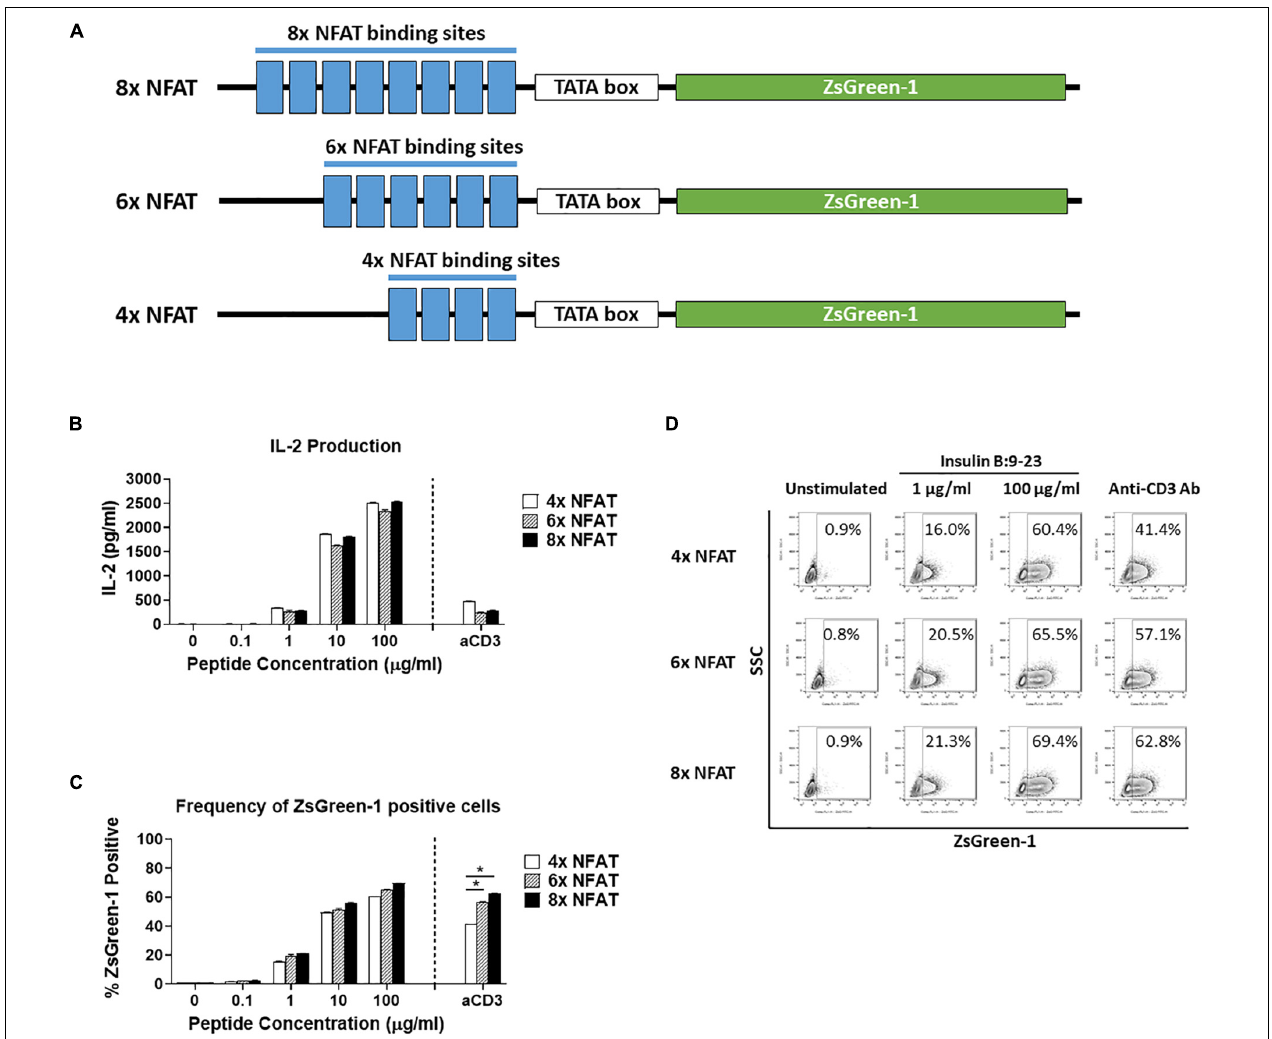
FIGURE 2 | Comparison of number of NFAT binding site repeats. (A) Schematic showing the three NFAT-reporter constructs used in the experiments, containing either four, six, or eight copies of the NFAT binding site. (B–D) GSE.6H9 TCR 5KC T-hybridoma cells transduced with an NFAT-reporter construct containing four, six, or eight copies of the NFAT binding site were cultured with anti-CD3 antibody or different concentrations of the cognate peptide, insulin B:9-23, in the presence of K562 cells expressing HLA-DQ8. IL-2 production in culture supernatant was measured by ELISA (B) , and frequency of ZsGreen-1-positive 5KC T-hybridoma cells was measured by flow cytometry using the gating strategy shown in Supplementary Figure S1 (C) . Mean values ± SEM from experiments performed in duplicate are shown. * p -values calculated by unpaired t -test were < 0.01. (D) Representative flow cytometry contour plots showing percentage of ZsGreen-1-positive cells containing either the 4x NFAT, 6x NFAT, or 8x NFAT construct. Unstimulated cells containing each construct are included to show the baseline fluorescent intensity that was used to establish gate placement for ZsGreen-1 positive cells. All results are representative of three independent